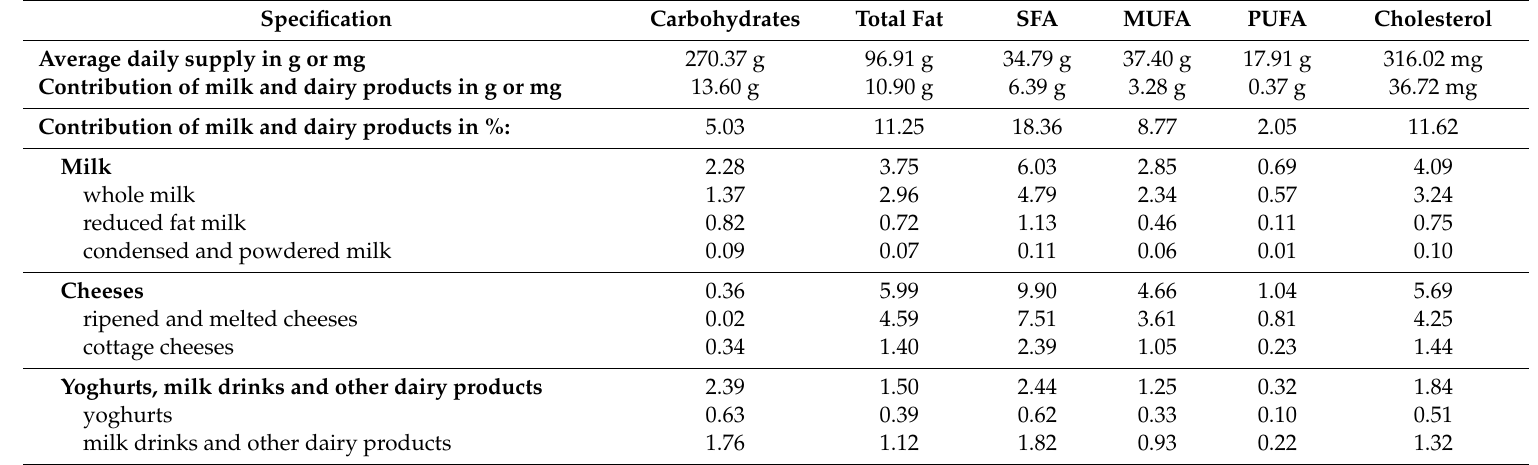
Table 5. Dairy sources of macronutrients contribution to the average Polish diet (in g or mg and %). Specification